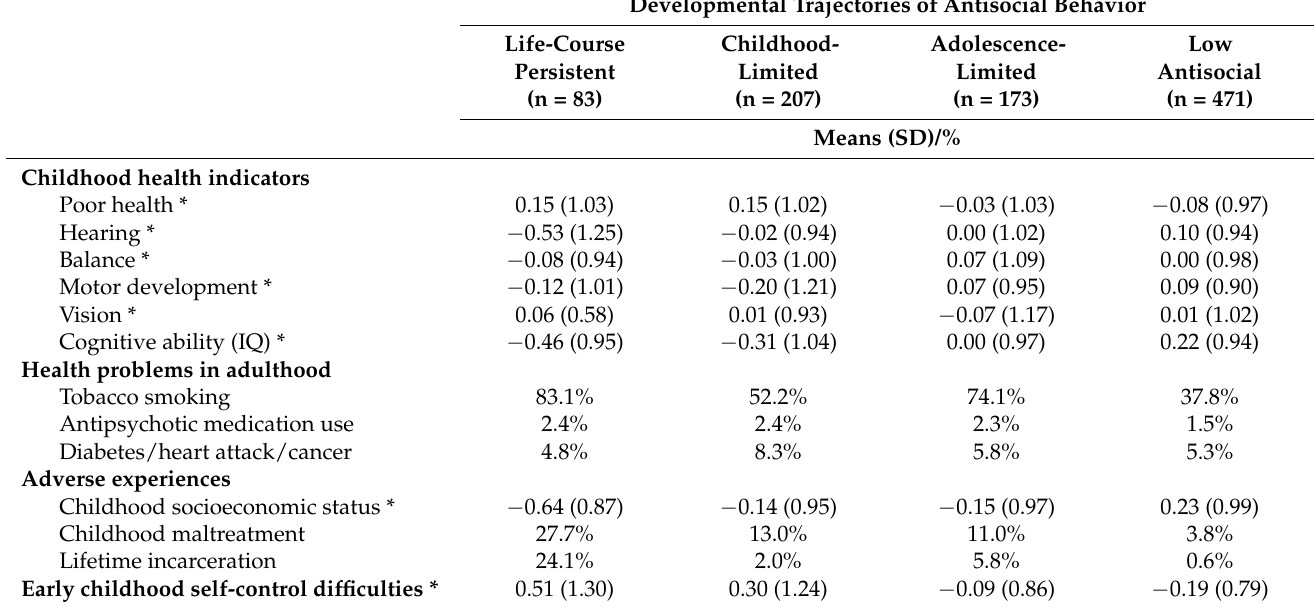
Table 1. Health histories, adverse experiences, and self-control difficulties among individuals in the four developmental trajectories of antisocial behaviors. These measures are used as covariates in esti- mating associations between developmental trajectories of antisocial behavior and aging